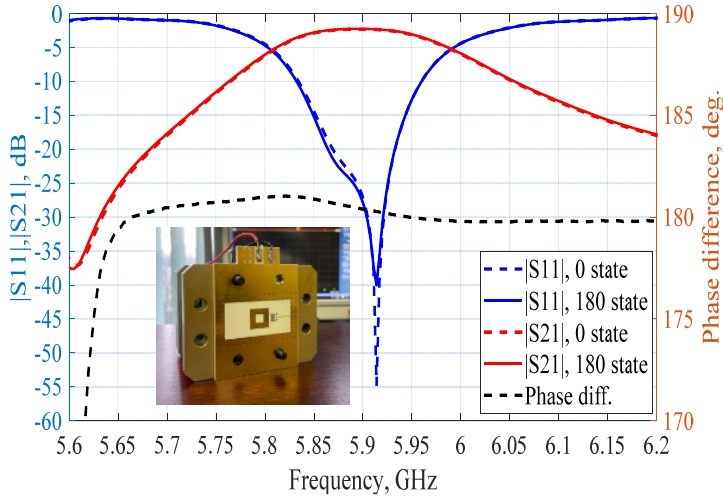
Figure 6. Measured scattering parameters and differential phase shift of the proposed reconfigurable unit cell structure and insets fabricated prototype of the reconfigurable unit cell structure inside a rectangular waveguide. Table 1. Comparison of reconfigurable unit cell realization using p-i-n-diodes. Ref.